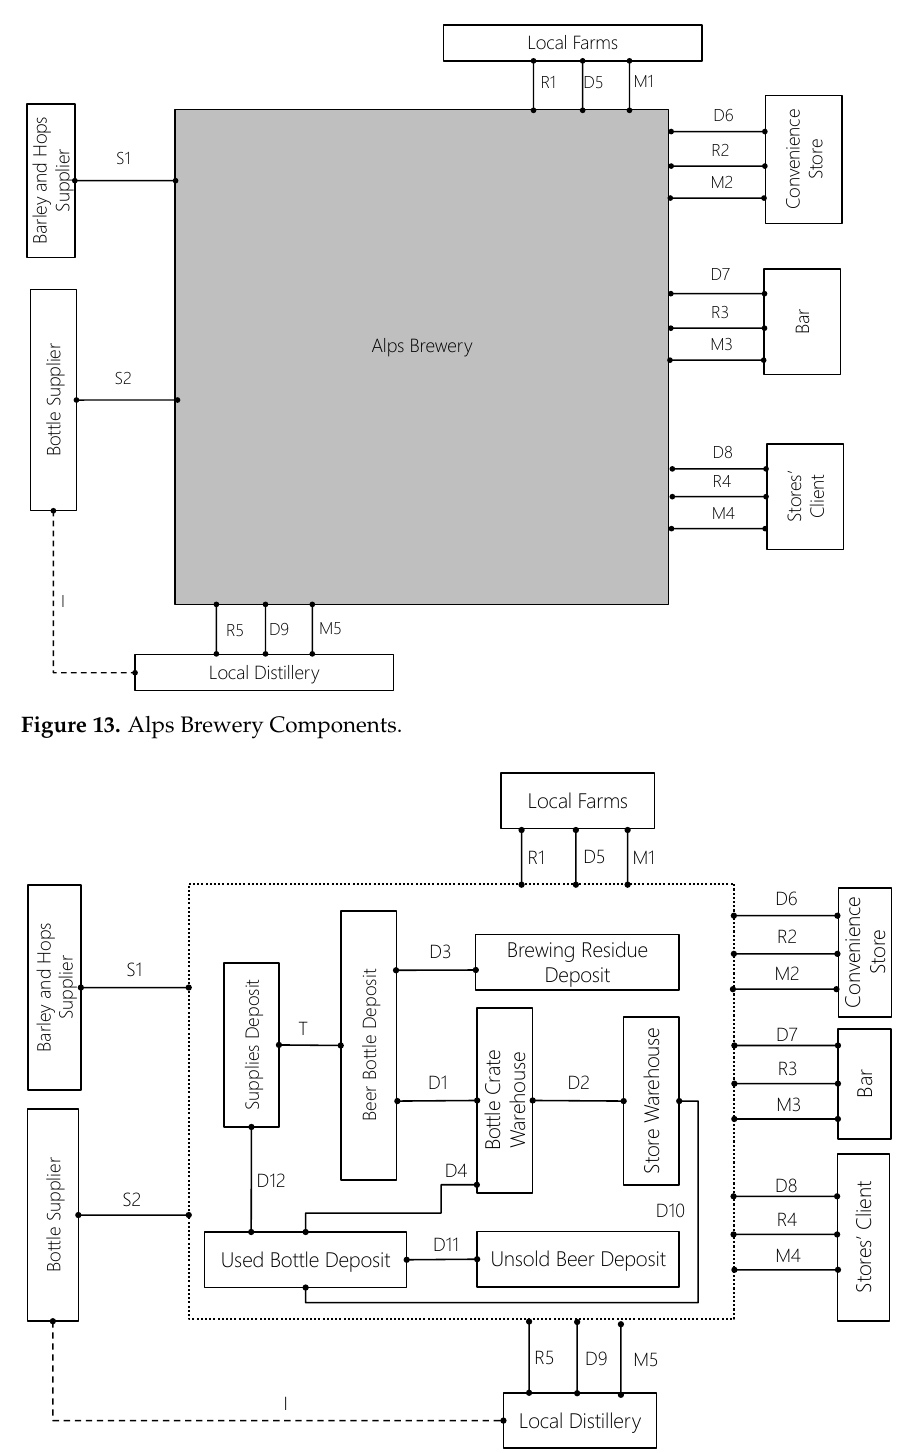
Figure 14. Alps Brewery Components detailed